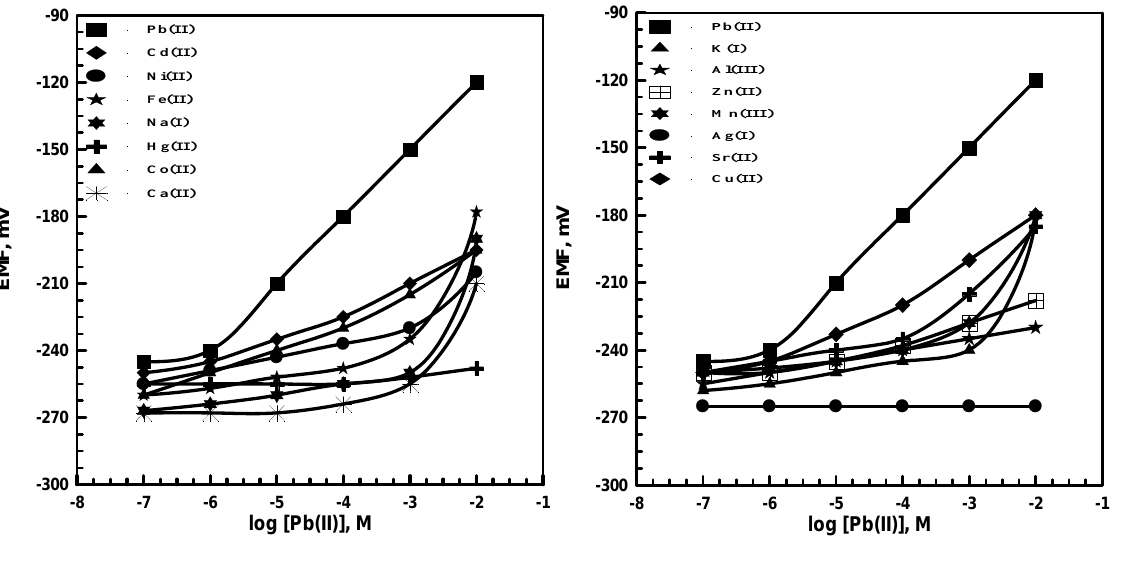
Figure 3. Potentiometric responses of lead membrane sensors based on (TP) with additive as ionophore toward several metal ions.